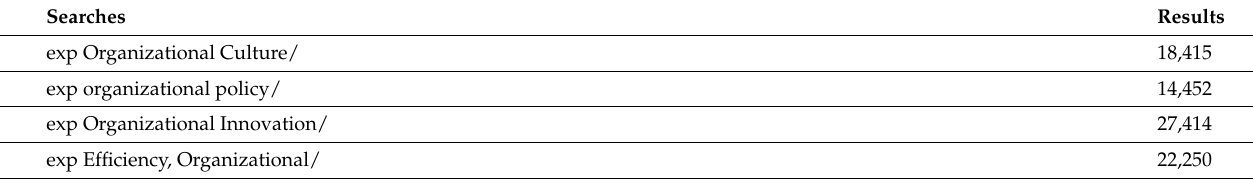
Table A1. Sample Search